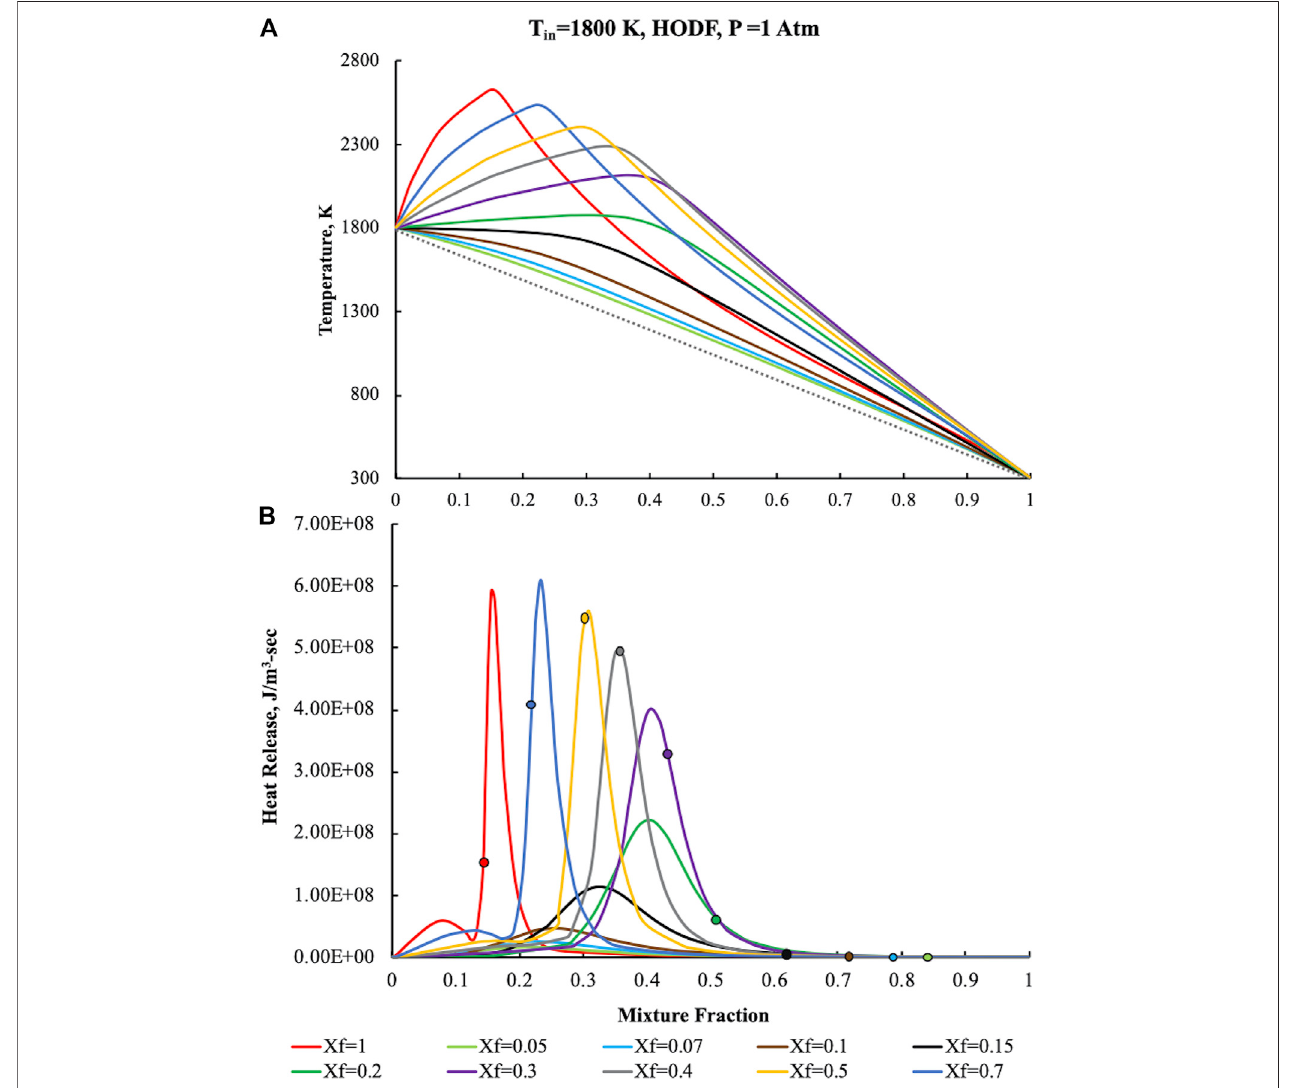
FIGURE 9 | Temperature (A) and heat release (B) pro fi les for pure ammonia, parametric in X f , in the HODF con fi guration for T in (cid:1) 1,800 K, K 0 (cid:1) 50 s − 1 , P (cid:1) 1 Atm.